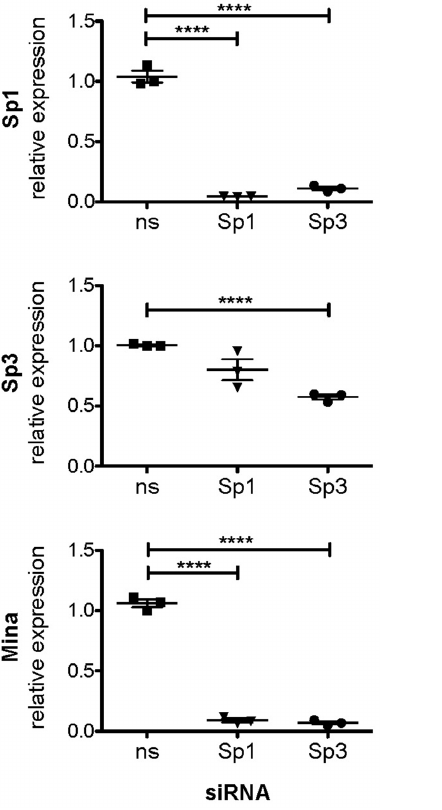
Figure 5. Effect on Mina expression of siRNA knockdown of Sp1/3. EL4 cells were transfected with GAPDH- and two different Sp1/ 3-specific as well as one non-specific Accell SMART pool siRNA and cultured for 72 hours, prior to real time RT-PCR analysis of relative mRNA levels of GAPDH, Sp1, Sp3 and Mina. Shown is a representative result from 3 independent experiments. Statistical significance of triplicate measurements was determined by the student’s t-test (****p ,